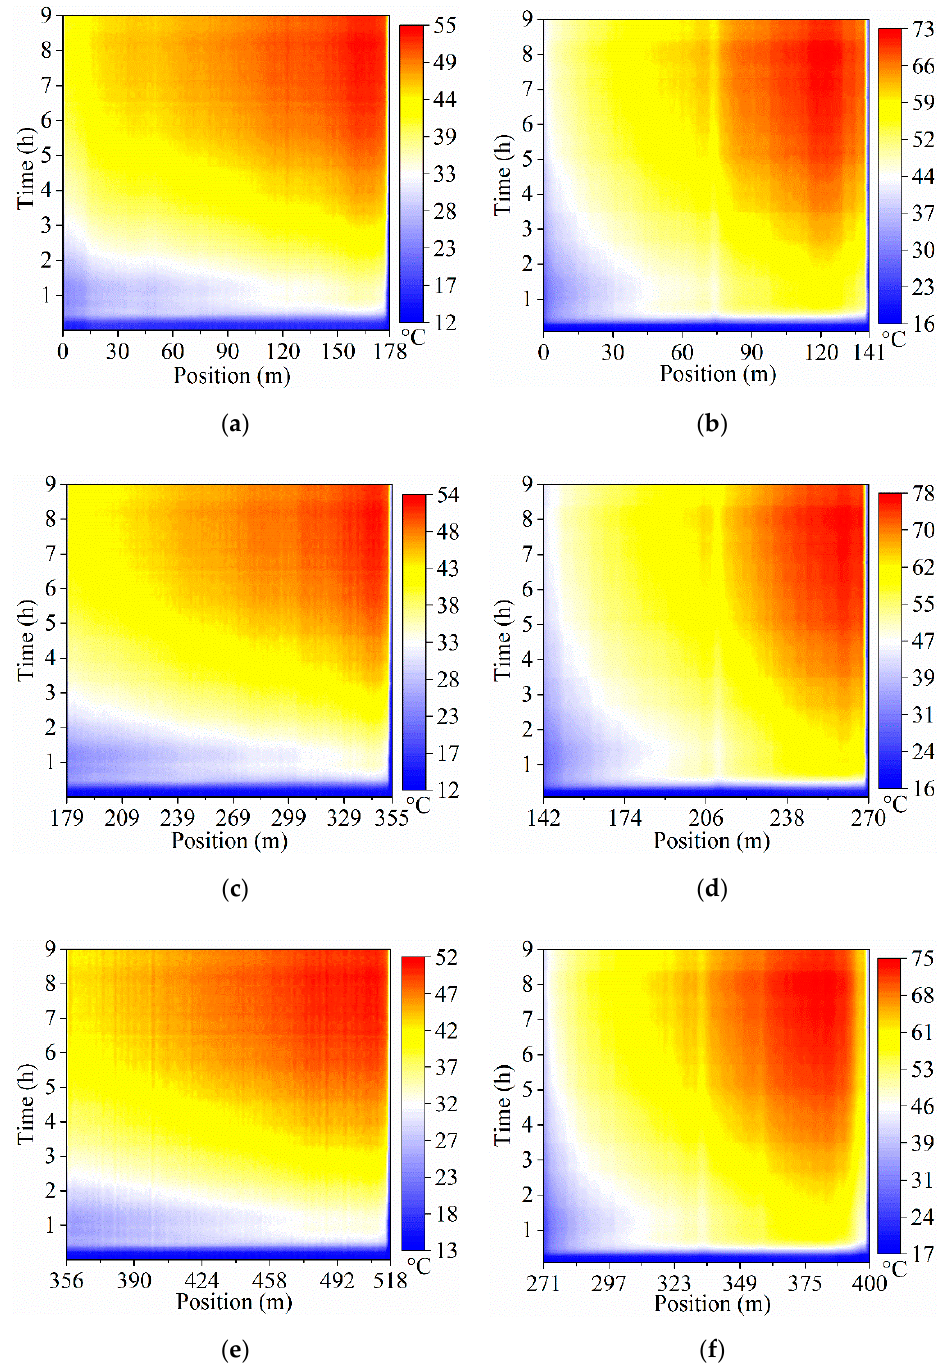
Figure 9. Spatiotemporally continuous temperature distribution along the ( a , c , e ) HV winding, phase A, B, and C, respectively and ( b , d , f ) LV winding, phase A, B, and C, respectively.